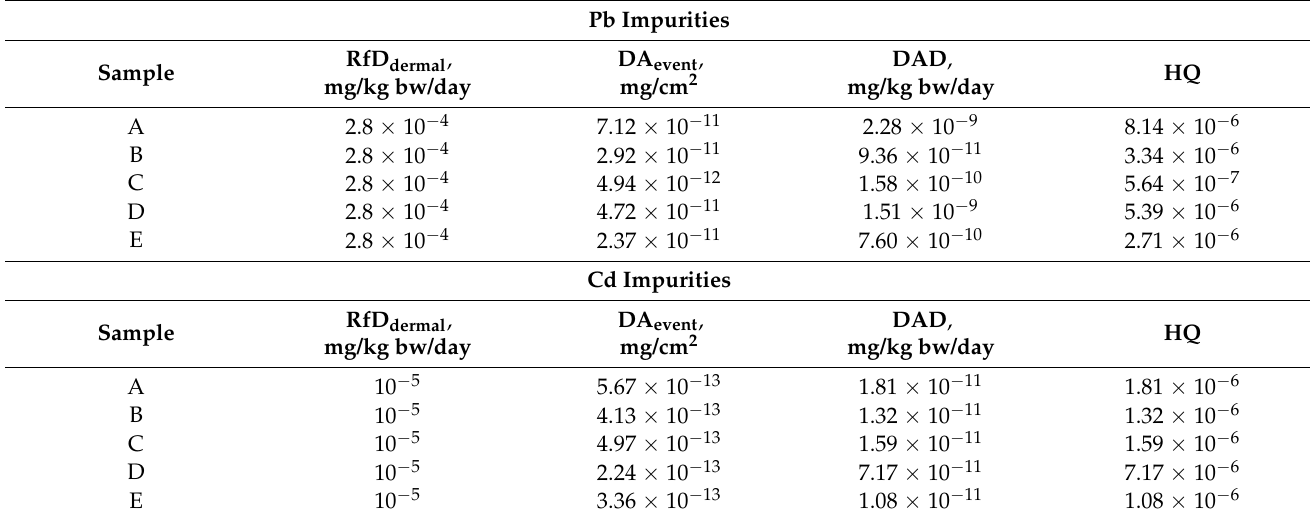
Table 5. Summary of the human health risk assessment of the USEPA model for Pb and Cd impurities in ointments with marjoram herb extract (Majoranae herbae extractum) via the dermal route. Pb